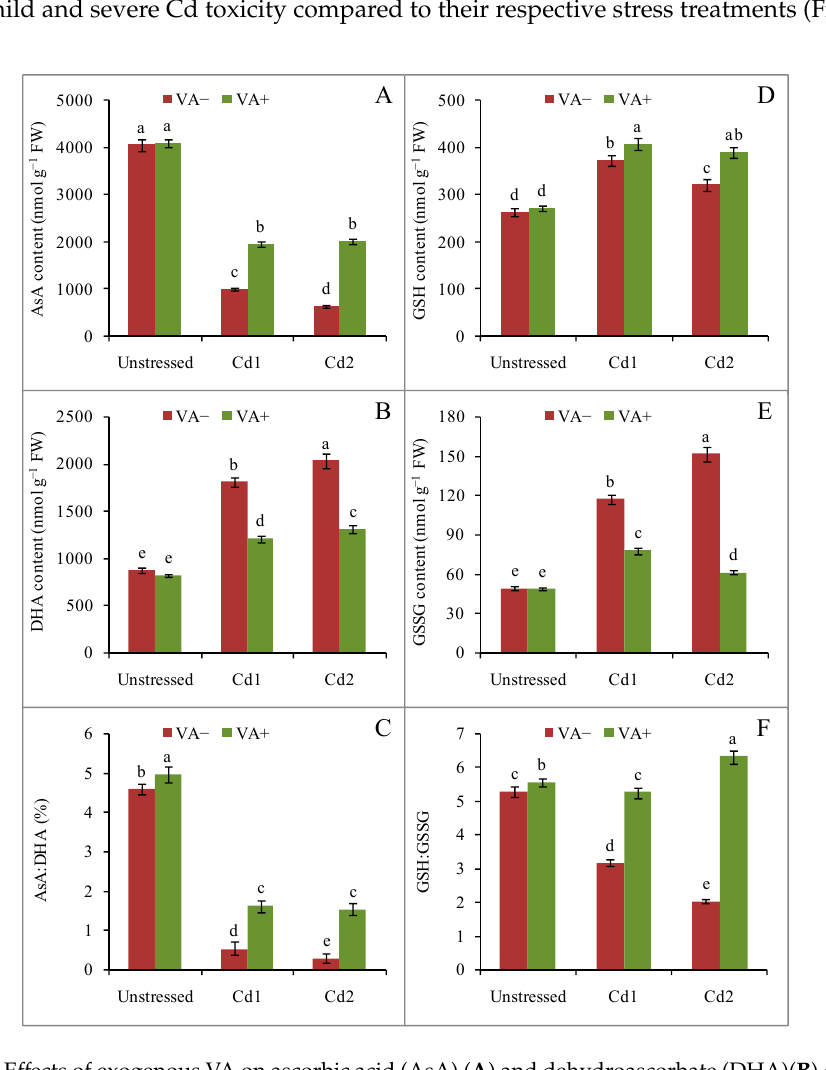
Figure 5. Effects of exogenous VA on ascorbic acid (AsA) ( A ) and dehydroascorbate (DHA)( B ) contents, AsA/DHA ratio ( C ), reduced glutathione (GSH) ( D ) and oxidized glutathione (GSSG) ( E ) contents, and GSH/GSSG ratio ( F ) of rice ( Oryza sativa L. cv. BRRI dhan54) seedlings under Cd stress. Mean (±SD) was computed from three replications of each treatment. Bars with dissimilar letters are significantly different at p ≤ 0.05 from Fisher’s least significant difference (LSD) test .